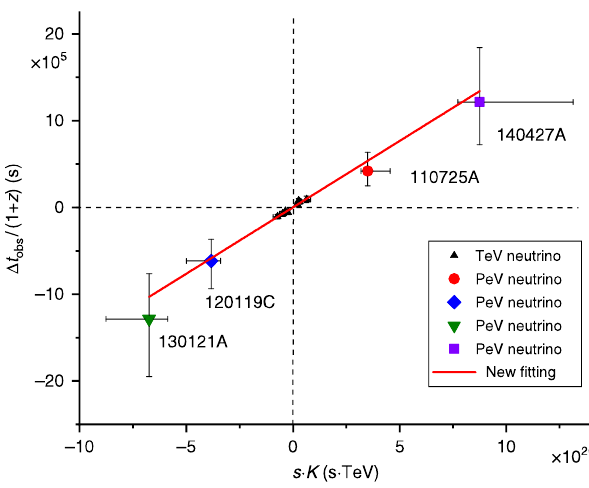
Figure 1 . Linear fit presented in ref. [25] to arrival time differences between GRB-neutrinos and -photons measured by IceCube. The vertical axis shows the observed arrival time difference corrected by the redshift factors (1 + z ) − 1 of the GRBs in consideration (to take into account the expansion of the universe). The horizontal axis displays the K factor of eq. (5) in ref. [25] where a sign s is taken into account for the late events. Both high-energy TeV events and four PeV events are shown in the